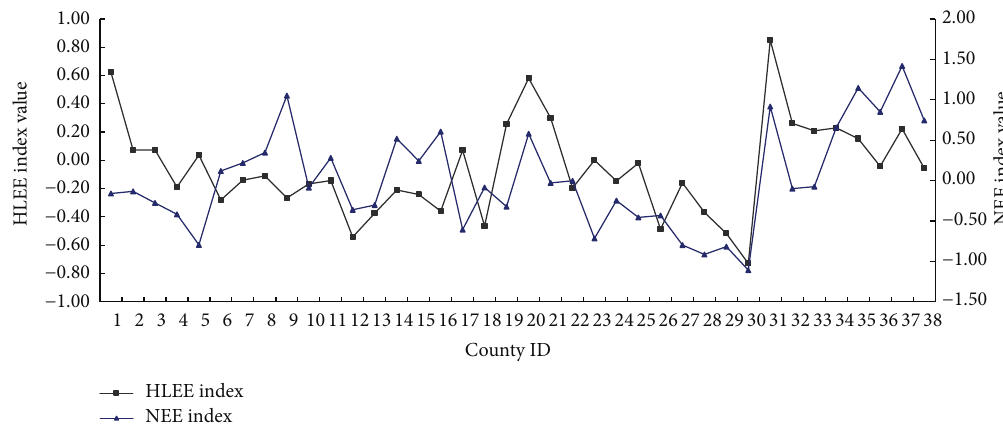
Figure 2: The curve of human living environmental evaluation (HLEE) index and natural environmental evaluation (NEE) index (1: